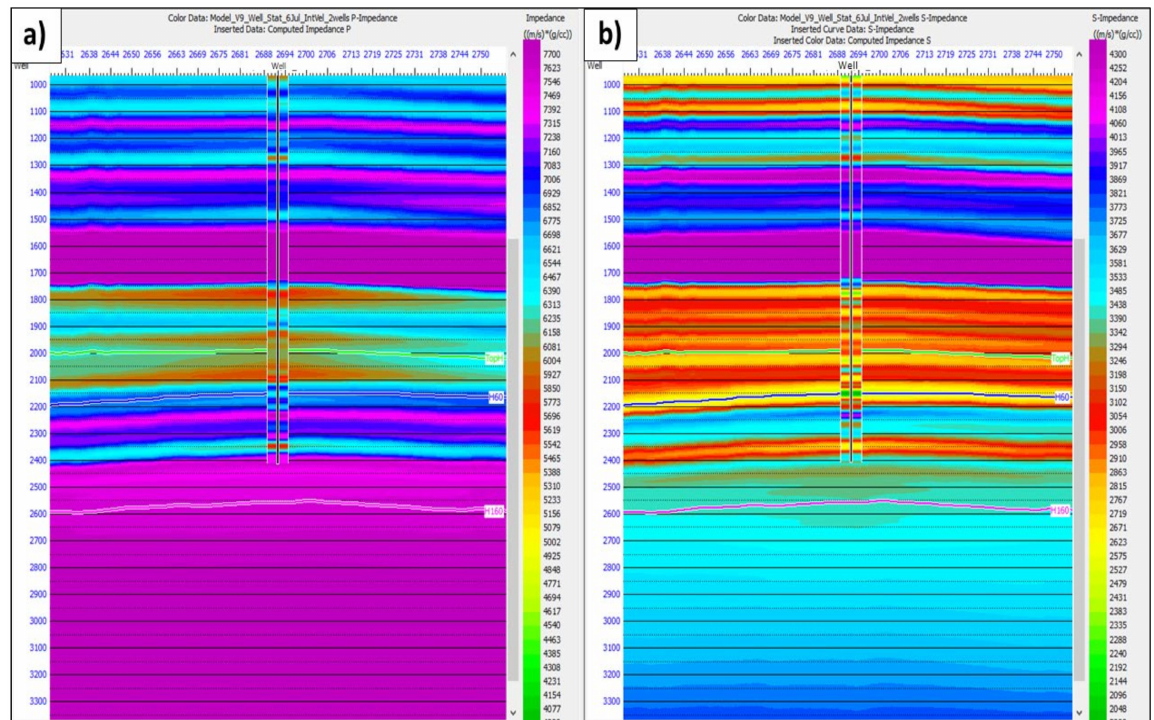
Figure 13. Initial seismic model of ( a ) P-impedance and ( b ) S-impedance.